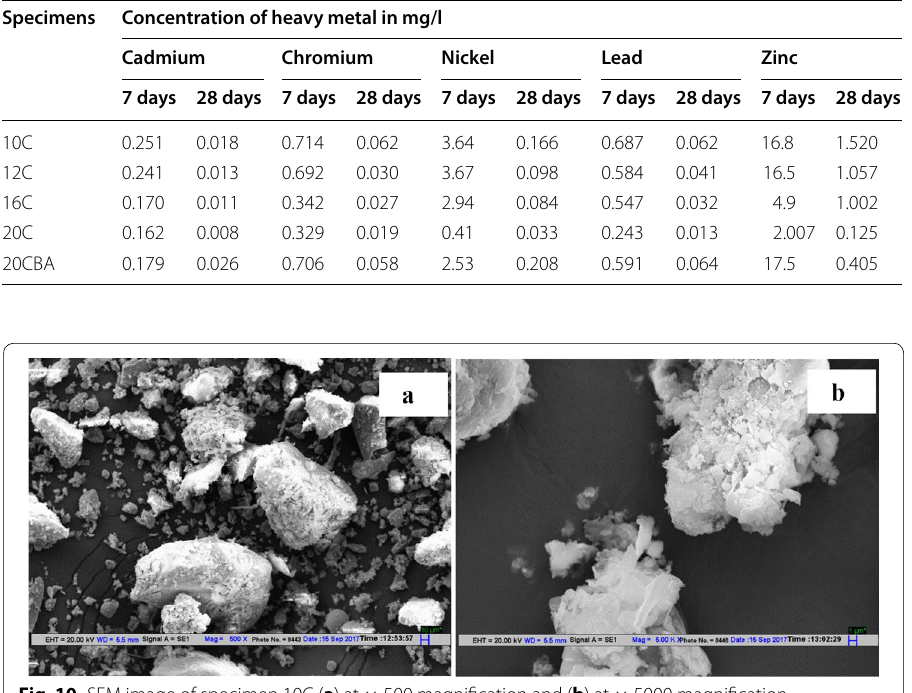
Fig. 10 SEM image of specimen 10C ( a ) at